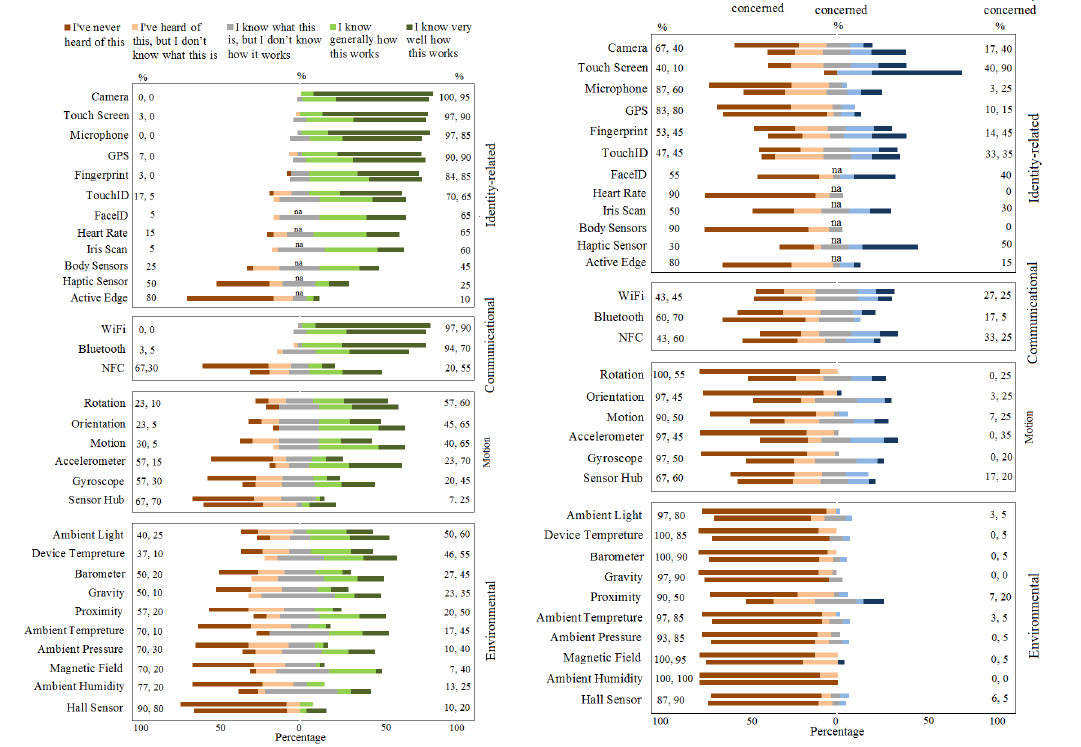
Figure 4. ( Left ) Self-declared knowledge of sensors; ( right ) self-declared perceived risk of sensors. Top bars and left percentages are for Workshop 1 (2016); bottom bars and right percentages are for Workshop 3